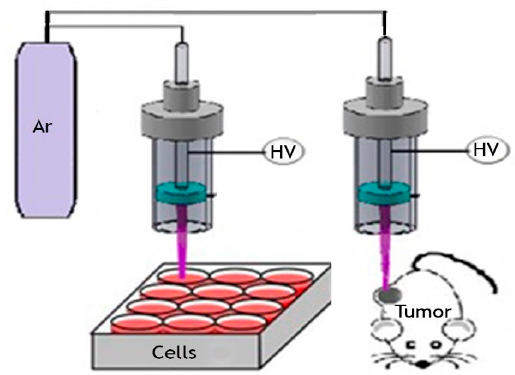
Figure 1. Schematic of the argon-seeded plasma jet applied in vitro and in vivo.